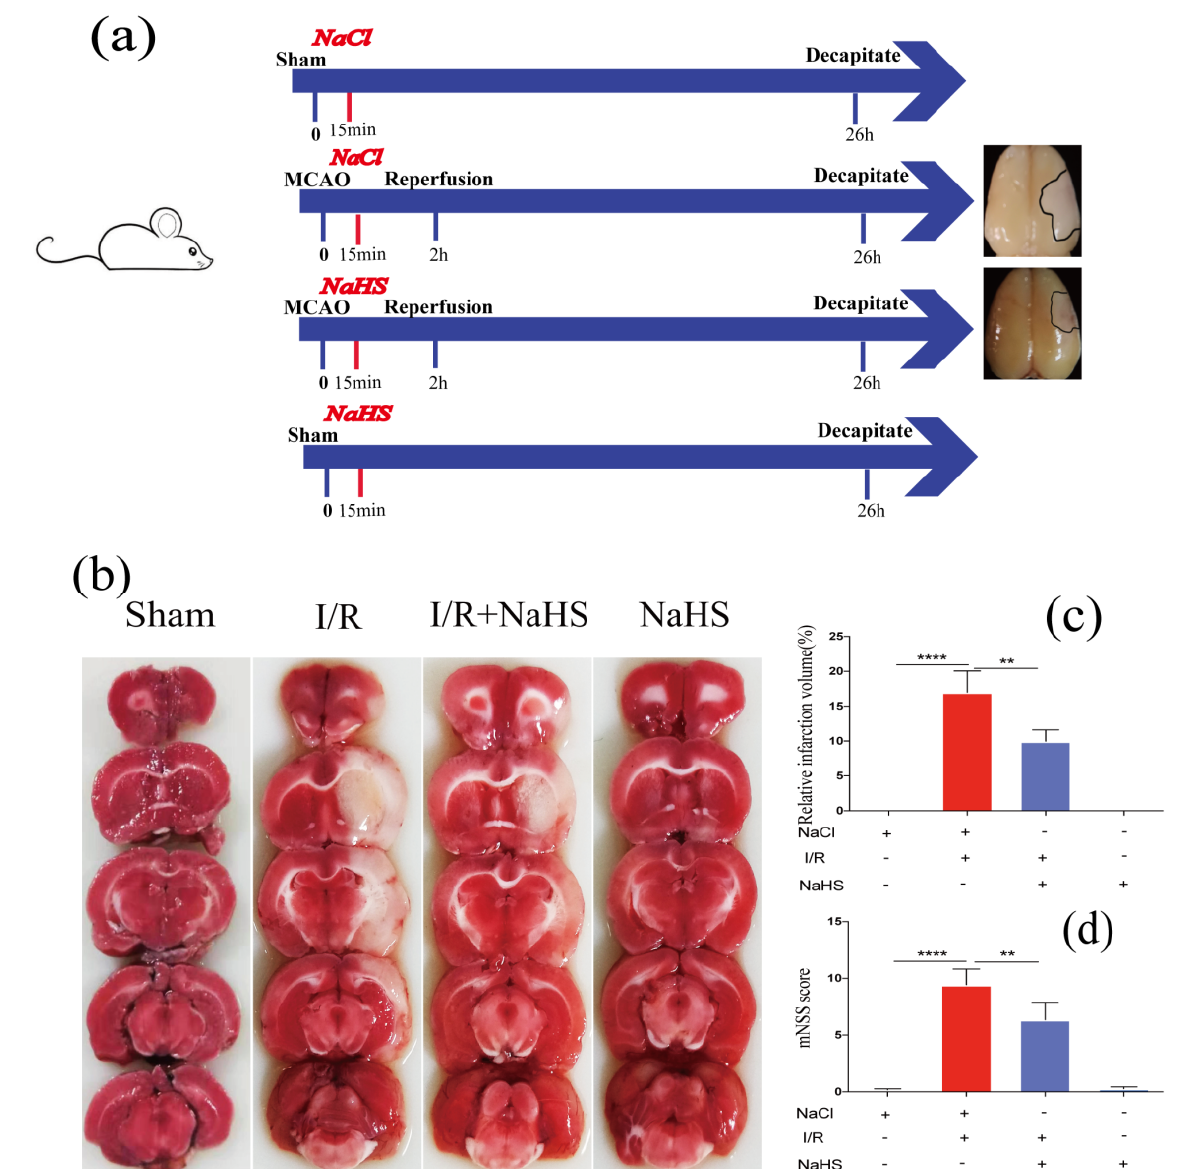
Figure 1. NaHS rescued neurological deficits and ischemic infarction of I/R rat. ( a ) The schematic of experimental procedures. ( b ) Images of brain TTC staining in each group. ( c ) The quantitative analysis of infarct volume. ( d ) Neurological deficit was evaluated by the mNSS scoring system 24 h post I/R. Data are presented as the means ± SD, n = 5, ** p < 0.01, **** p < 0.0001.